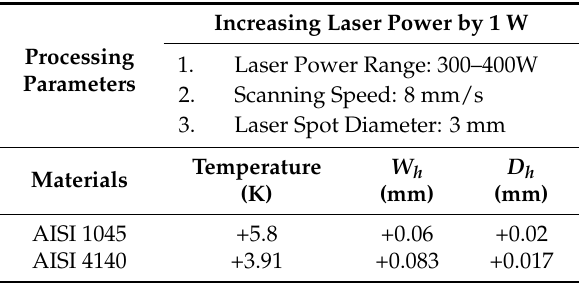
Table 4. Recommended processing parameters to increase hardening